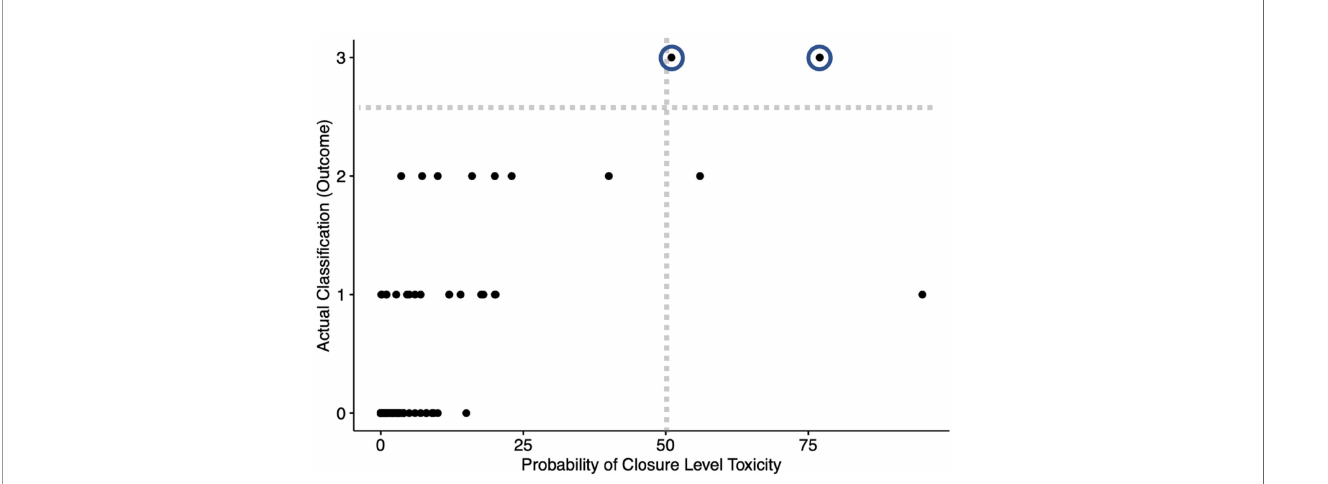
FIGURE 2 | Toxicity classi fi cation levels at all sites/times where a forecast was made for the 2021 season, compared to the probability of a closure predicted one week ahead of time. Classi fi cations represent toxicity levels measured in shell fi sh, with level 3 representing a closure-level toxicity (toxicity for classi fi cation levels 0-3 are, respectively, 0-10, 10-30, 30-80, and >80 µg SAX eq 100 g -1 shell fi sh). The circled points represent the two closure-level events that occurred, both correctly